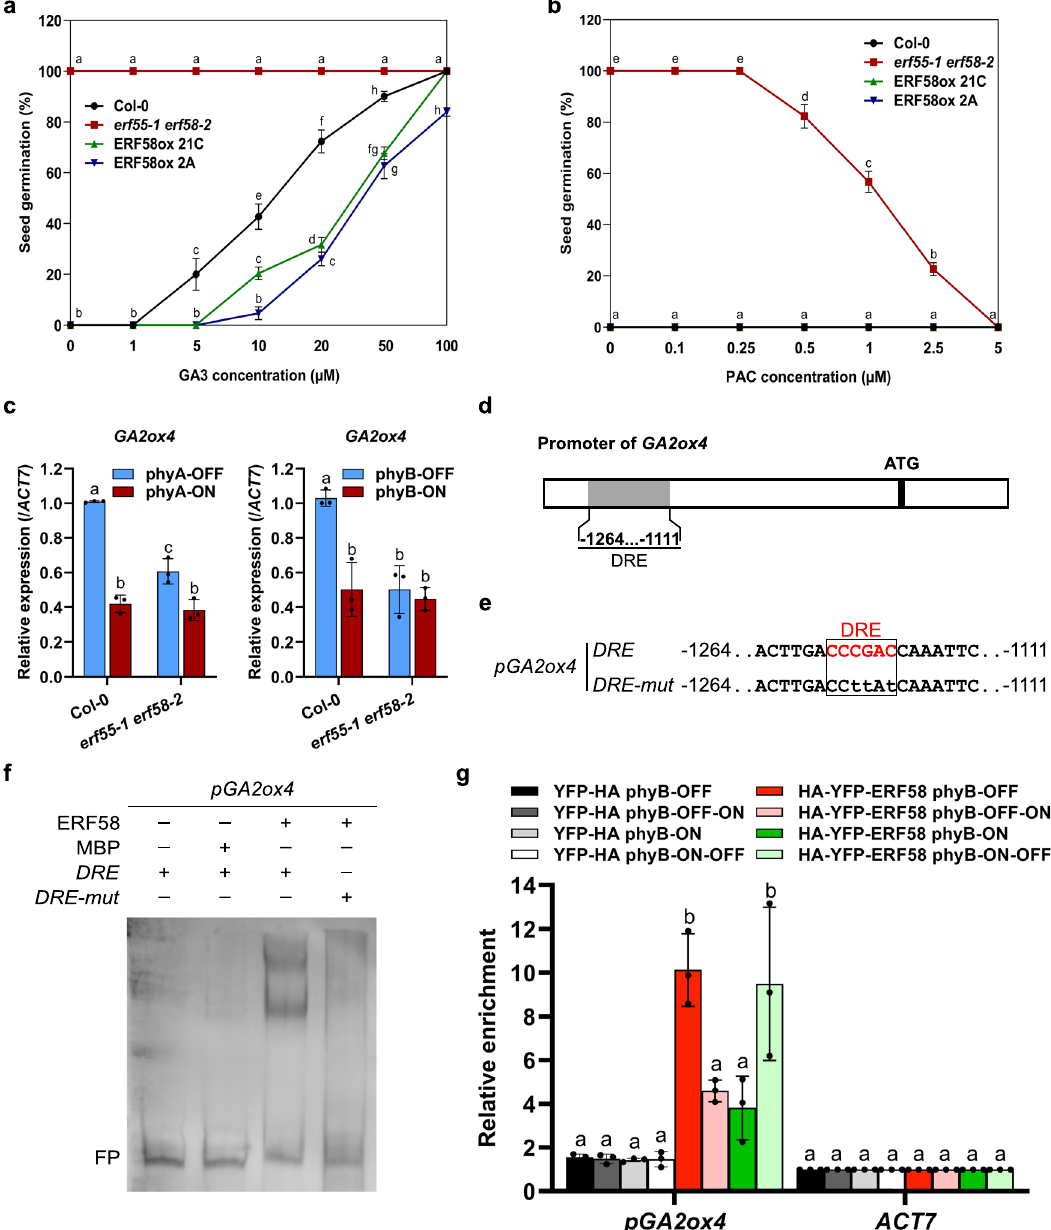
Fig. 7 ERF55 and ERF58 regulate the expression of genes encoding GA metabolic enzymes. a , b Completion of germination of wild-type (Col-0), erf55-1 erf58-2 double mutant, and ERF58ox (two independent lines) seeds on ddH 2 O and increasing concentrations of GA3 ( a ) or the GA biosynthesis inhibitor PAC ( b ). Seeds were not exposed to light ( a ) or exposed to W light for 6 h ( b ); after 7 days incubation in the dark at 22 °C, seeds were scored for completion of germination. Data points show mean cumulative germination percentages of three replicates ±SD. c RT-qPCR analysis of GA2ox4 expression levels in Col-0 and erf55-1 erf58-2 seeds incubated under phyA-ON/OFF or phyB-ON/OFF conditions; data for other genes encoding GA metabolic enzymes are shown in Supplementary Fig. 15. Light conditions are described in Supplementary Fig. 6a, b. ACT7 was used as an internal control. Values show means of three replicates ±SD. d , e Schematic representation of the GA2ox4 promoter. The promoter fragment used for EMSA is shown in e . f EMSA. Biotin-labelled GA2ox4 − 1111 … − 1264 promoter fragments containing a wild-type or mutated DRE motif were incubated with MBP-ERF58 or MBP alone (negative control). Samples were analysed by native PAGE. The gel was blotted onto a nylon membrane and signals were detected by streptavidin-coupled horseradish peroxidase and ECL. FP, free probe. The experiment was repeated fi ve times with similar results. Data for ERF55 are shown in Supplementary Fig. 13c. g ChIP-qPCR. Germinating seeds of Col-0 p35S:HA-YFP-ERF58 (line 21C) and Col-0 p35S:YFP-HA (negative control) were subject to light treatments as described in Fig. 4a. Chromatin was isolated and HA-YFP-ERF58 bound DNA fragments were puri fi ed using α -GFP coupled magnetic beads. qPCR and speci fi c primers were used to detect the GA2ox4 − 1111 … − 1264 promoter fragment in the eluate fraction. ACT7 was used for normalisation. Values show enrichment of the GA2ox4 promoter fragment in the eluate fraction compared to the input fraction and are means of three replicates ±SD. a – c , g Different letters indicate signi fi cant differences as determined by two-way ANOVA followed by post-hoc Tukey ’ s HSD test. a – c p < 0.05. g p < 0.01.